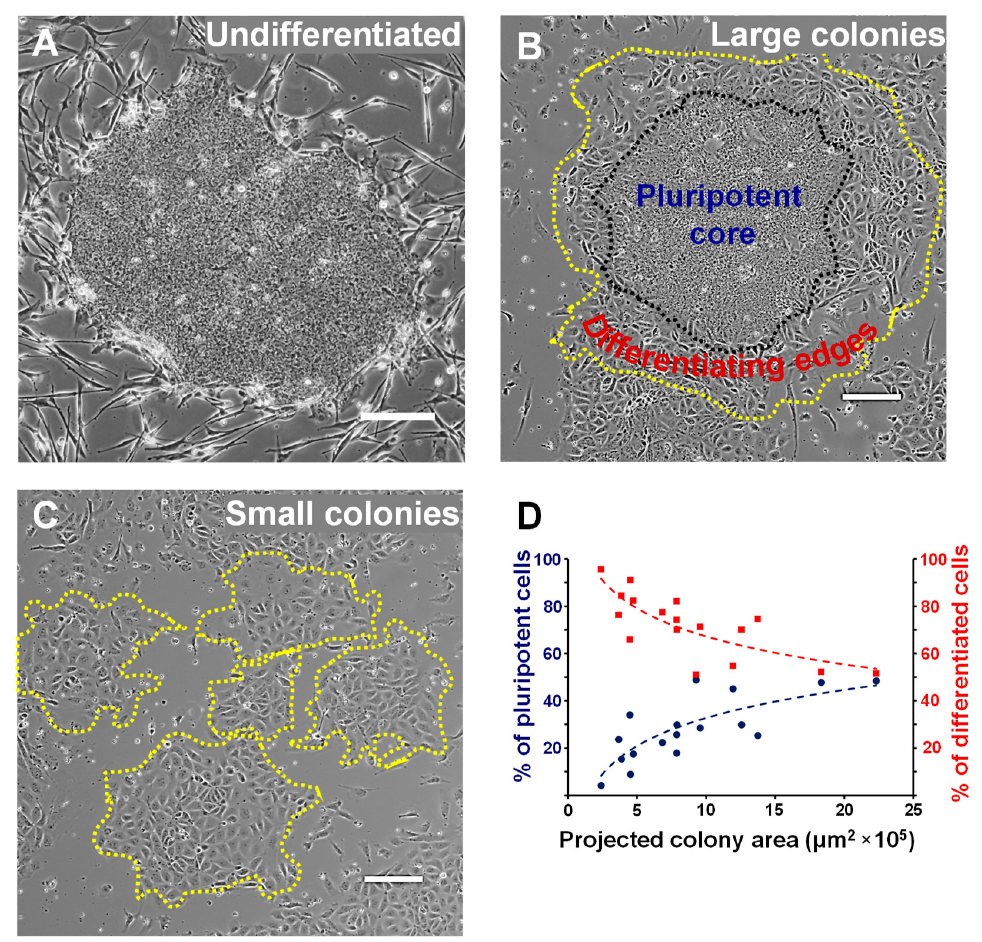
Figure 1. EpiSC differentiation heterogeneity is caused by the physical size of the colony. ( A ) A phase image of an EpiSC colony displays a pluripotent morphology on mitotically inactivated feeders using standard culture protocol. ( B , C ) Phase images of EpiSCs on fibronectin-coated surfaces reveal significant heterogeneity in EpiSC differentiation as a function of colony size. When the colony size was small, differentiation was homogeneous. As the colony size increased, pluripotency was conserved in the center while differentiation was observed only on the colony periphery. ( D ) The percentage of pluripotent and differentiated cells within the individual colonies is represented as a function of the total colony area. n = 17 colonies from three independent experiments. Scale bar, 200 µm.